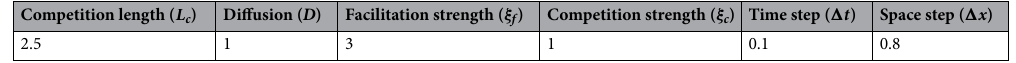
Competition length ( L c )